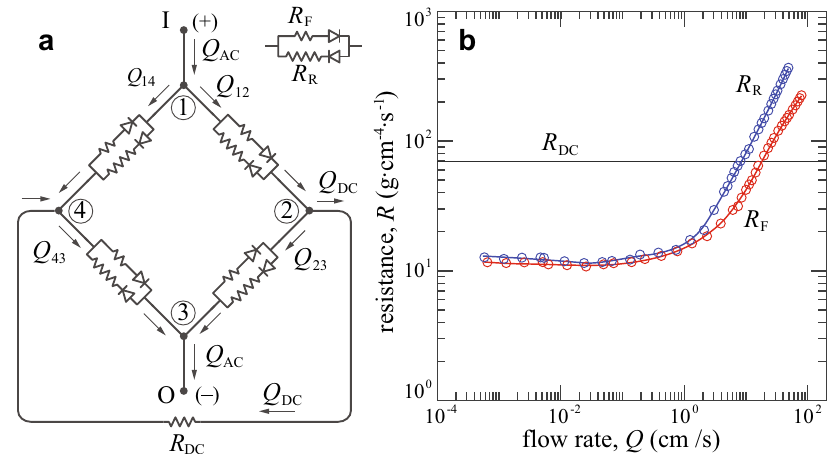
Fig. 8 Circuit model with nonlinear resistances. a Equivalent electronic circuit of the fl uidic AC-to-DC converter, where the Tesla conduit is modeled as a `leaky diode ’ with asymmetric resistance values. b Resistances vs. fl ow rate for forward (red) and reverse (blue) fl ow through Tesla ’ s conduit, as inferred from the data shown in Fig. 2. The DC branch resistance value is estimated via the Hagen-Poiseuille